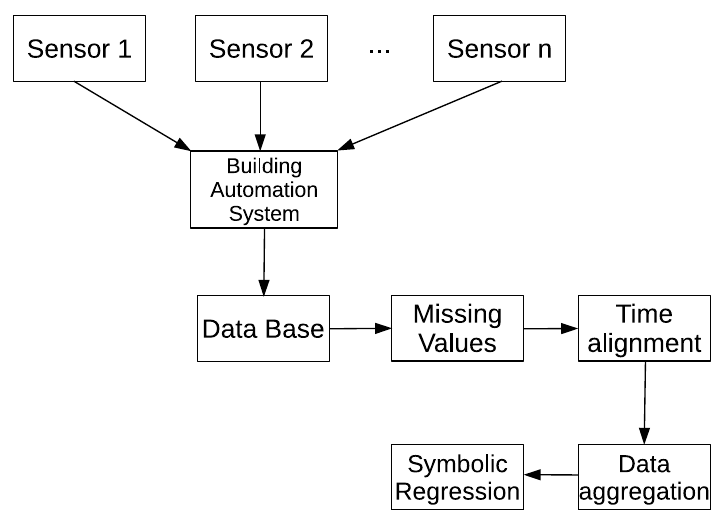
Figure 4. Building Automation System (BAS) and data preprocessing.